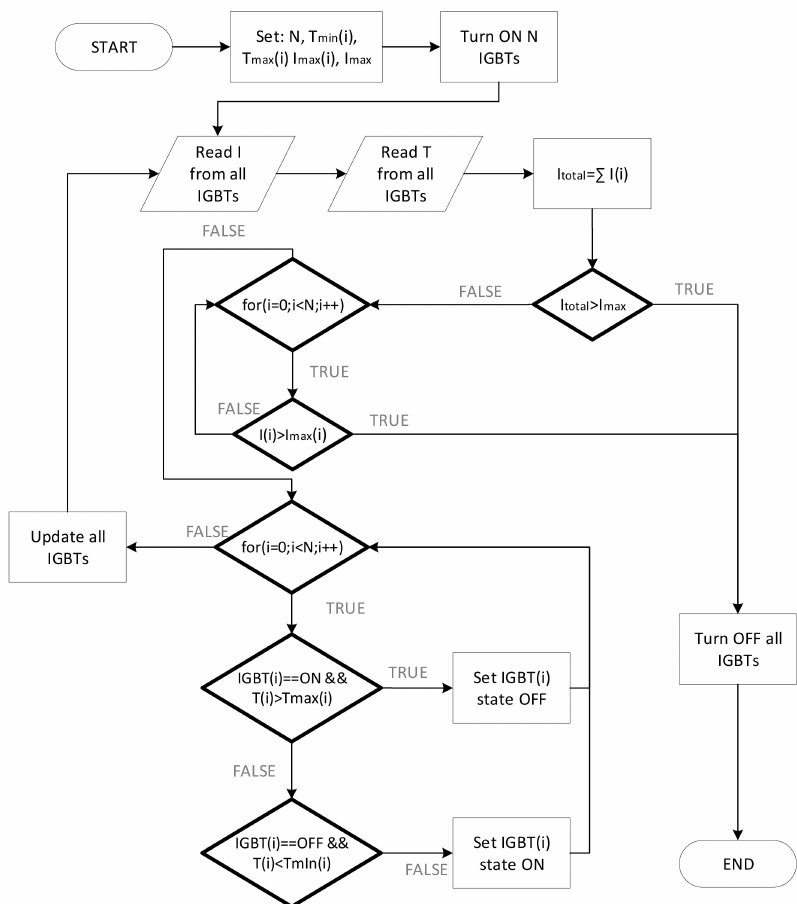
Figure 4. Flowchart of the Nsim